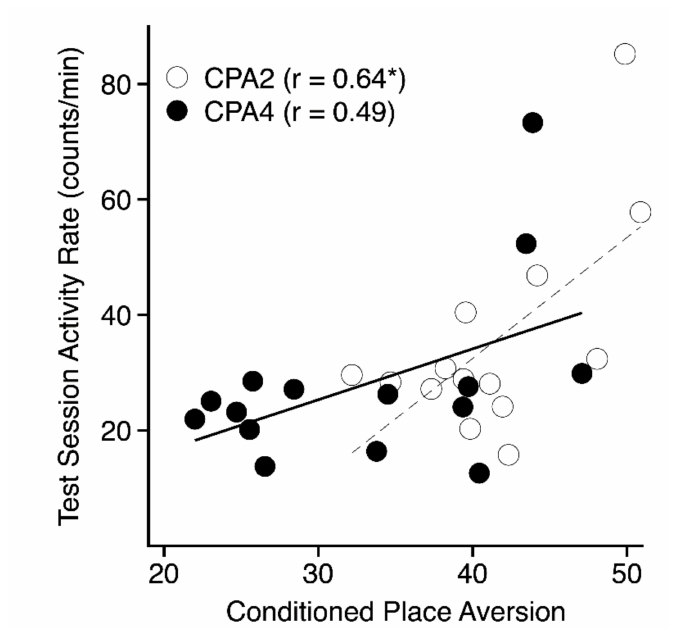
Figure 5. Scatterplot depicting the genetic correlations between mean test session activity rates (y-axis) and conditioned place aversion indexed as mean percent time on the ethanol-paired floor (x-axis) for the 2- (open symbols, dashed line) and 4- (closed symbols, solid line) g / kg groups. Each point represents the strain mean scores for both